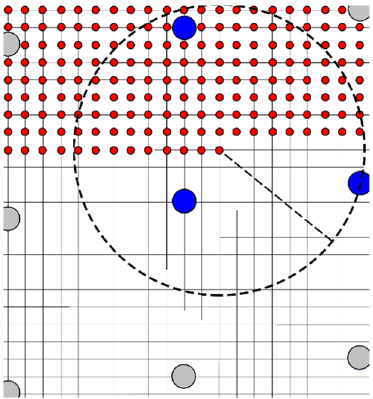
Figure 9. Searching for influencing points.